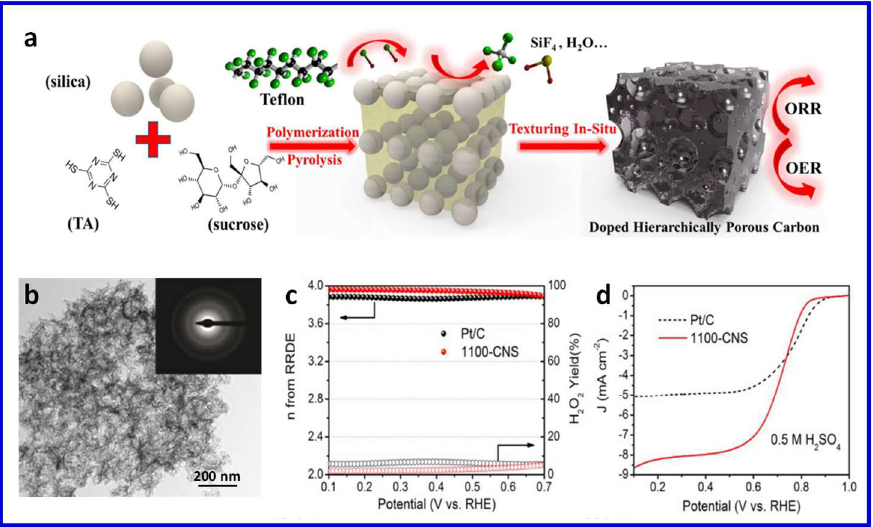
Figure 9. ( a ) Illustration of the one-pot fabrication process of N, S-doped porous carbon (CNS) materials; ( b ) TEM observation of the CNS sample, inset is the SAED patterns; ( c ) RRDE voltammograms of the 1100-CNS and Pt/C samples at 1600 rpm; ( d ) Electron transfer number (n) and HO 2− yield derived from the RRDE test. Reproduced from [118], Copyright 2017, The Royal